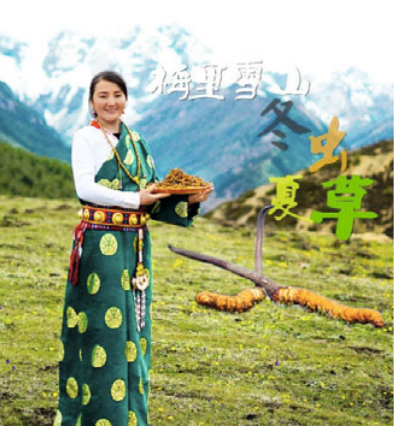
Fig. 1. Advertisement. Translation from Chinese: “Meili Snow Mountain”, “Winter worm summer grass”.